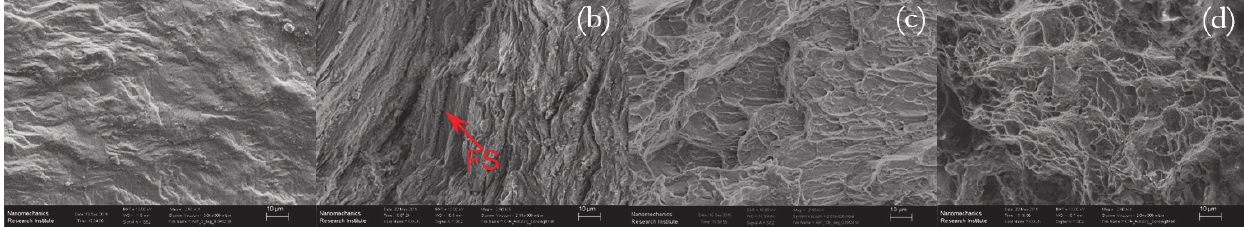
Figure 7: SEM images showing a comparison of crack propagation zone (a, b) and final fracture (c, d) between the as-extruded (a, c) and forged (b, d) of fatigue fracture surfaces tested at the total stress amplitude of (a) 90 MPa for the base sample, and (b) 120 MPa for the forged